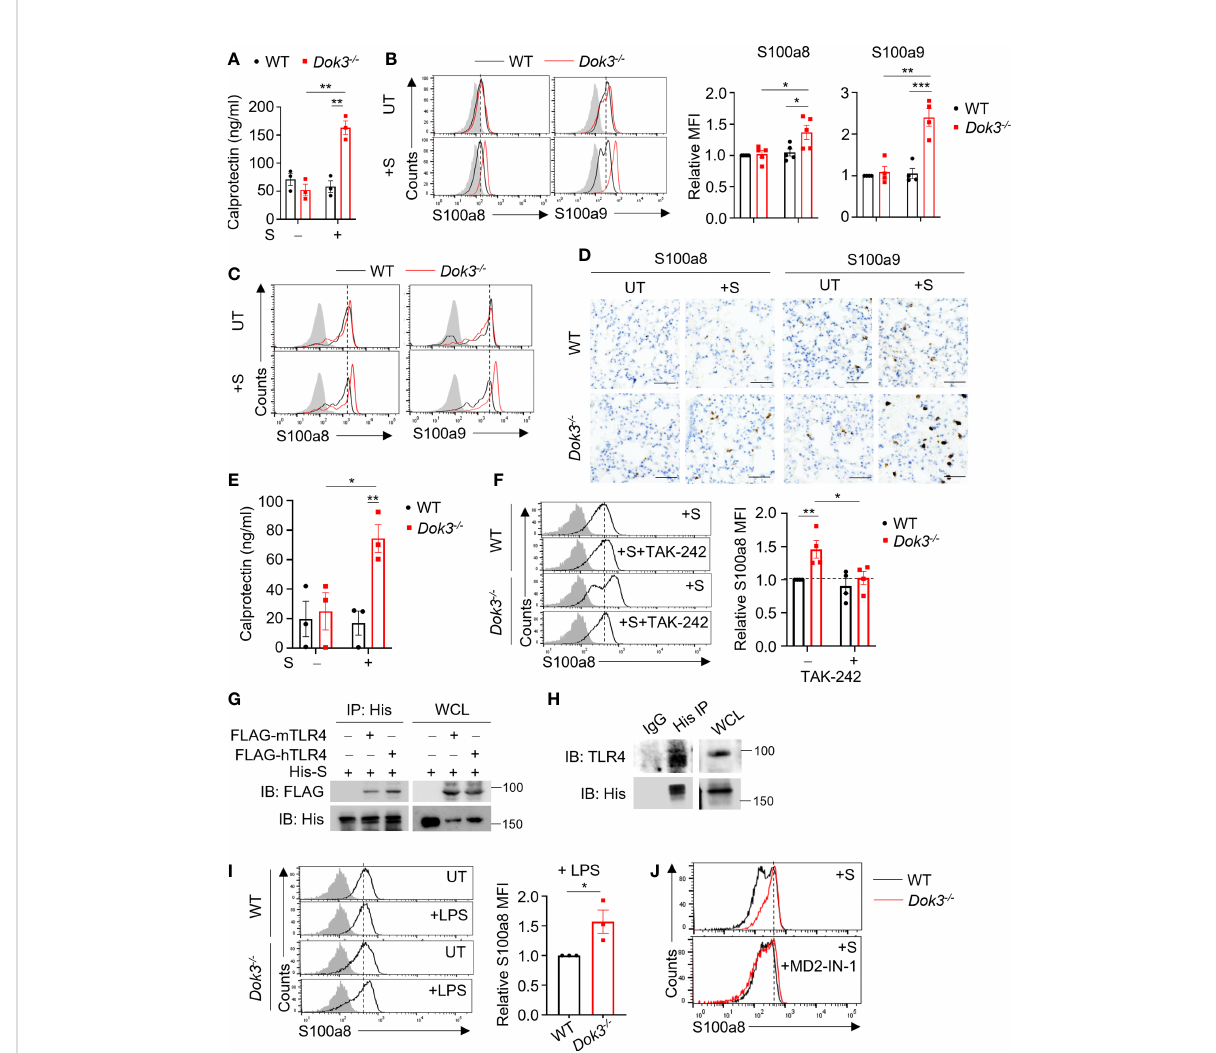
FIGURE 1 Dok3 suppresses calprotectin production by neutrophils in response to SARS-CoV-2 S protein through a TLR4-dependent pathway. (A) WT and Dok3 -/- neutrophils were stimulated with or without S protein for 5h. Calprotectin level in culture medium is measured by ELISA. Data is shown as mean ± S.E.M. (n = 3, 3 independent experiments). **p = 0.002, unpaired two-tailed Student ’ s t-test. (B) Flow cytometric analysis of S100a8 and S100a9 expression in WT and Dok3 -/- neutrophils following 3h stimulation with S protein. Histograms were pre-gated on singlet, Ly6G + cells. Filled histogram represents isotype control. Bar graph depicting MFI of S100a8 or S100a9 fl uorescence in Dok3 -/- neutrophils relative to WT neutrophils. Data is shown as mean ± S.E.M. (n = 5, 5 independent experiments). *p = 0.02, 0.03, **p = 0.002, ***p = 0.001, unpaired two- tailed Student ’ s t-test. (C and D) Lungs were harvested from WT and Dok3 -/ - mice 24h after intranasal instillation of S protein. (C) Flow cytometric analysis of S100a8 and S100a9 expression in WT and Dok3 -/- neutrophils following S protein administration. Histograms were pre- gated on singlet, CD45 + , Ly6G + cells. Filled histogram represents isotype control. (D) Lung sections were stained with anti-S100a8 and anti- S100a9 antibodies. Scale bar, 50 m m. Data shown are representative of 3 biological replicates. (E) Circulating calprotectin levels in WT and Dok3 -/ - mice 24h after intranasal instillation of S protein are measured by ELISA. Data is shown as mean ± S.E.M. (n = 3). *p = 0.03, **p = 0.01, unpaired two-tailed Student ’ s t-test. (F) Flow cytometric analysis of S100a8 expression in WT and Dok3 -/- neutrophils following 3h stimulation with S protein in the presence or absence of TAK-242. Histograms were pre-gated on singlet, Ly6G + cells. Filled histogram represents isotype control. Bar graph depicting MFI of S100a8 fl uorescence relative to untreated WT neutrophils. Data is shown as mean ± S.E.M. (n = 4, 4 independent experiments). *p = 0.03, **p = 0.01, unpaired two-tailed Student ’ s t-test. (G) HEK293T cells were transfected with FLAG-tagged mouse (m) or human (h) TLR4. Cell lysates were incubated with His-tagged S protein and immunoprecipitated (IP) with anti-His antibody overnight. Precipitates and whole cell lysates (WCL) were immunoblotted with anti-FLAG and anti-His antibodies. Data shown are representative of 3 independent experiments. (H) WT neutrophils were incubated with His-tagged S protein and cell lysates were IP with anti-His or IgG control. Precipitates and WCL were probed for TLR4 and His. Data shown are representative of 3 independent experiments. (I) Flow cytometric analysis of S100a8 expression in WT and Dok3 -/- neutrophils following 3h stimulation with or without LPS. Histograms were pre-gated on singlet, Ly6G + cells. Filled histogram represents isotype control. Bar graph depicting MFI of S100a8 fl uorescence in Dok3 -/- neutrophils relative to WT neutrophils. Data is shown as mean ± S.E.M. (n = 3, 3 independent experiments). *p = 0.04, unpaired two-tailed Student ’ s t-test. (J) Flow cytometric analysis of S100a8 expression in WT and Dok3 -/- neutrophils following 3h stimulation with S protein in the presence or absence of MD2-IN-1. Histograms were pre-gated on singlet, Ly6G + cells. Filled histogram represents isotype